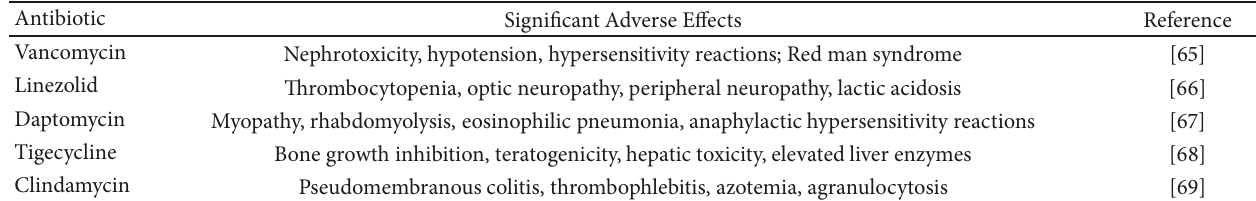
Table 2: Significant adverse effects seen with currently used